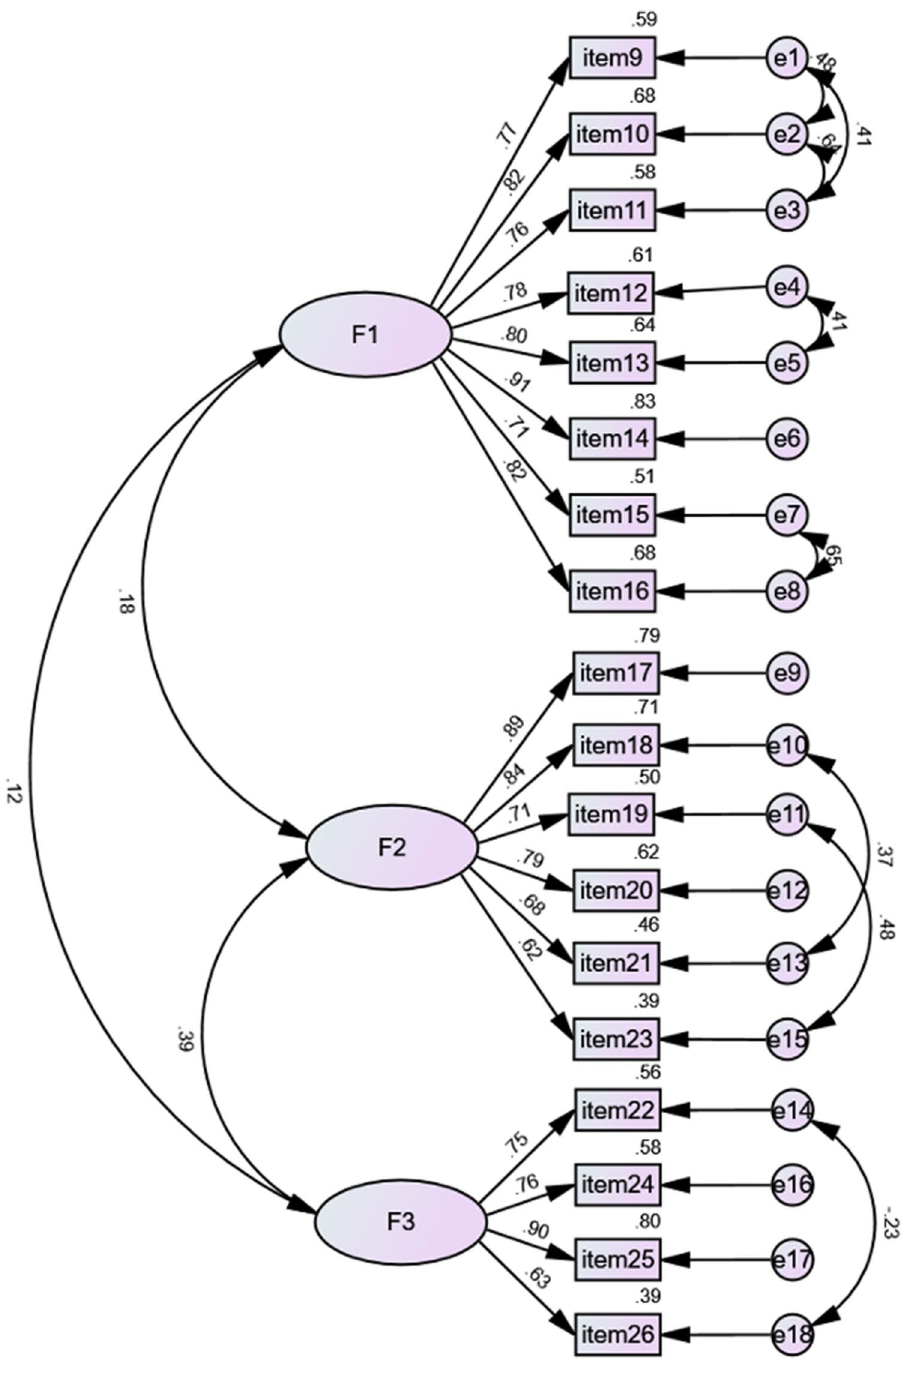
Figure 2. Factor structure model and estimated value of the standardized loadings of